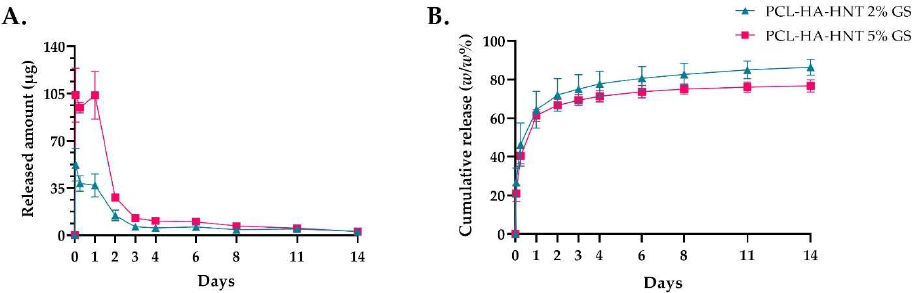
Figure 7. Released amount of GS (in µg) ( A ) and cumulative release ( w/w %) ( B ) from the PCL-HA- HNT 2% GS and 5% GS fixation plates after 1, 6 and 24 h and 2, 3, 4, 6, 8, 11 and 14 days. n = 3 replicates per group.